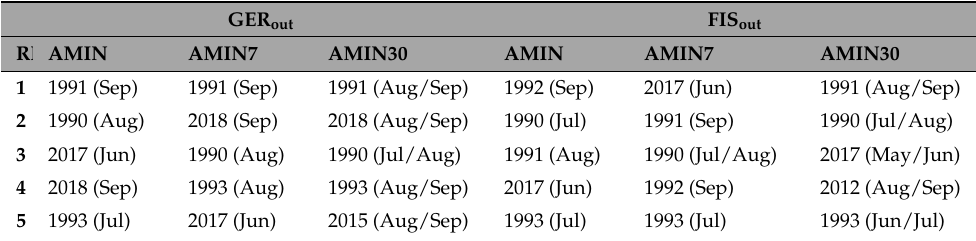
Table 6. Threshold values retrieved by averaging the AMIN, AMIN7, and AMIN30 time series.